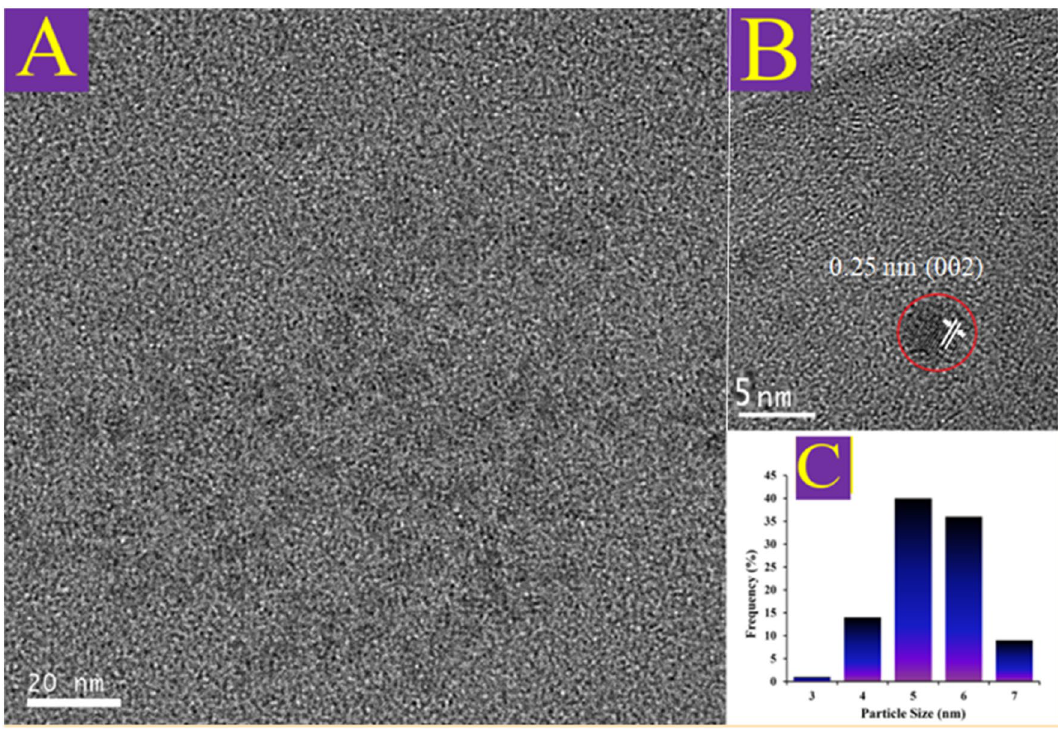
Figure 2. (A) TEM image of the A-CQDs/W; (B) The 5 nm resolution TEM image of A-CQDs/W, and (C) The size distributions of the